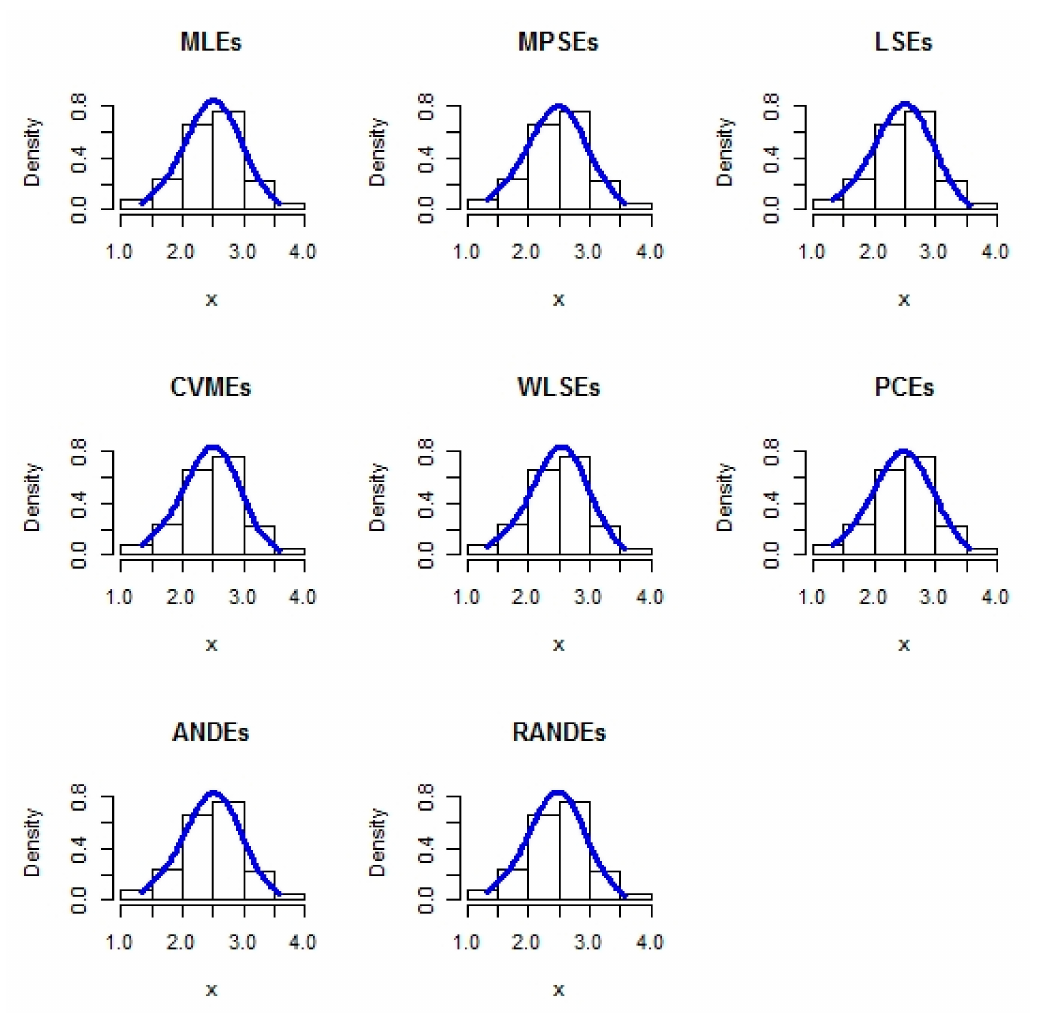
Figure 6. The histogram of the data and the fitted OEHLE densities using di ff erent estimation